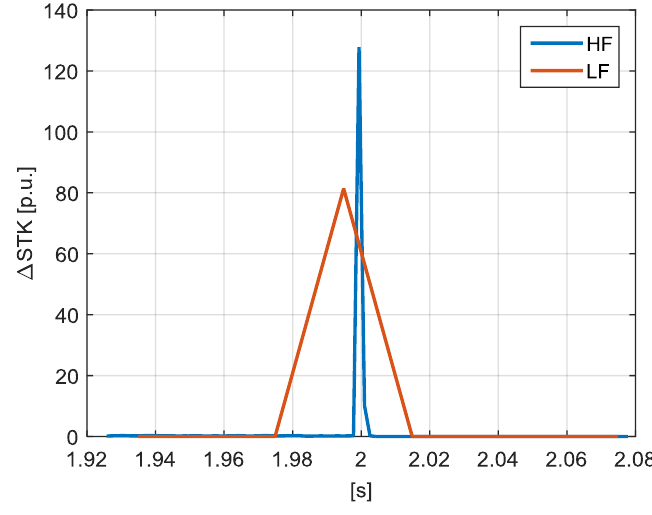
Figure 21. Case study 3: Δ STK at low-frequency (0 ÷ 2.4 kHz, red line) and at high-frequency (2.4 ÷ 150 kHz, blue line) obtained through the instantaneous approach.